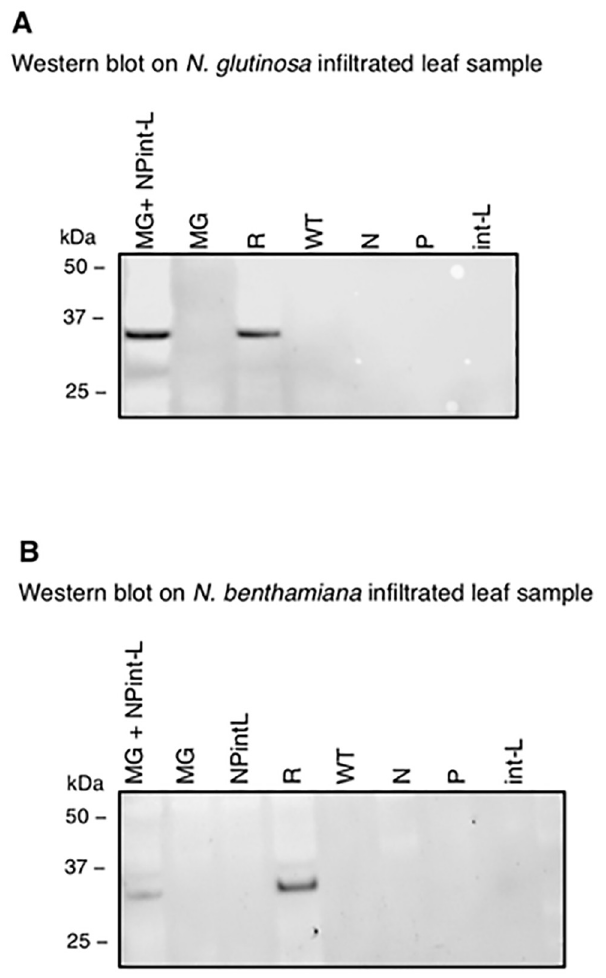
Fig 4. Detection of DsRed in agroinfiltrated Nicotiana . ( A ) DsRed protein detection using western blot in agro- infiltrated N . glutinosa . Infiltration was with MG cassette plus helper proteins (MG+NPint-L), MG alone (MG), helper proteins alone (N), (P), (int-L) and the positive control (R). WT is wild type non-infiltrated N . glutinosa . Bands were detected in samples infiltrated with MG cassette plus helper proteins (MG+NPint-L) and in positive control (R). ( B ) DsRed protein detection using western blot in agro-infiltrated N . benthamiana , samples are as in ( A ) but with an additional negative control (NPintL) consisting of infiltration of all helper